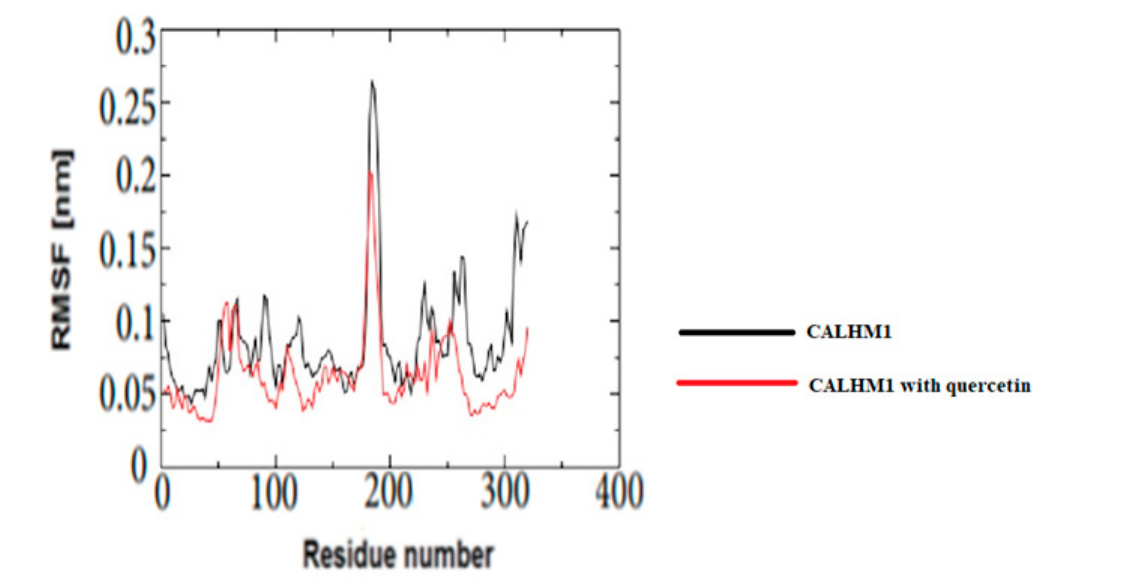
Figure 16. The RMSF values of unliganded CALHM1 and CALHM1–quercetin complex.